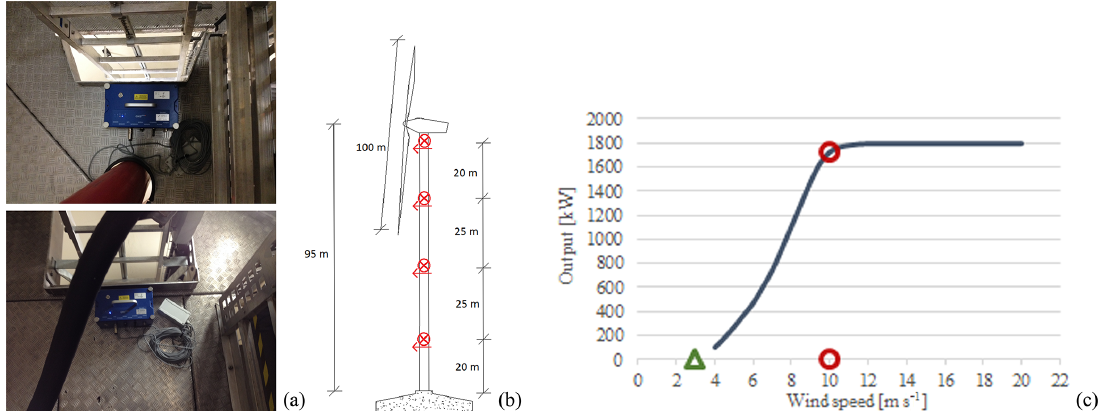
Figure 3. Ambient-vibration tests: (a) sensors, (b) section instrumented, (c) operating scenarios and power curve of Vestas V100 wind turbine (https://en.wind-turbine-models.com, last access: 4 November 2019).